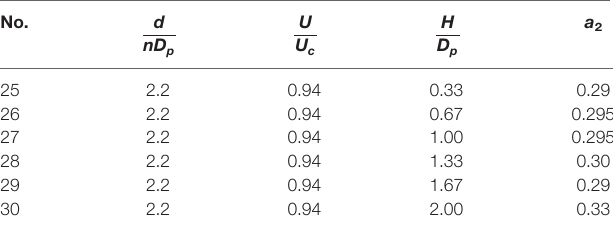
TABLE 3 | Values of a 2 in the work of Galan et al.